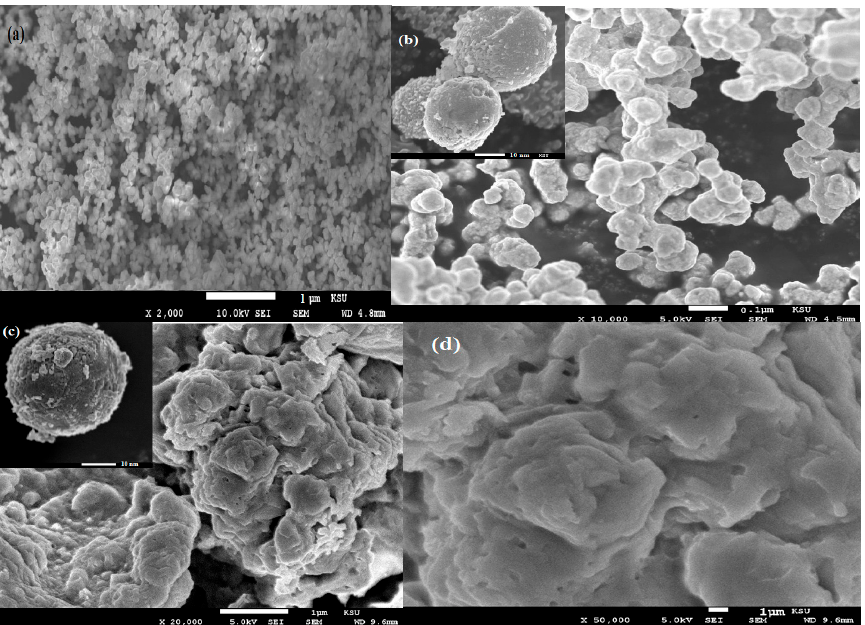
Figure 1 . SEM micrographs of ( a ) silica; ( b ) silica poly(sodium 2-acrylamido-2-methylpropane sulfonate (PAMPS-Na) included high resolution SEM at 10 nm on left top; ( c ) silica PAMPS-Na/ acrylamide (AAm) included high resolution SEM at 10 nm on left top; and ( d ) poly(acrylamide) (PAAm) nanogels.